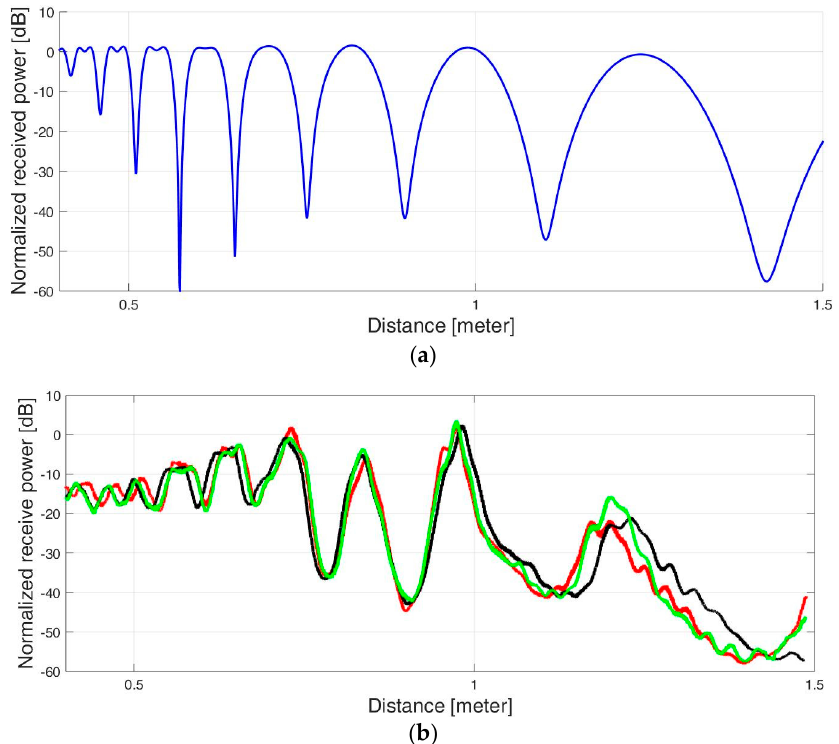
Figure 8. Four-ray model: ( a ) Analytical calculation. ( b ) Experimental results for three similar experiments.